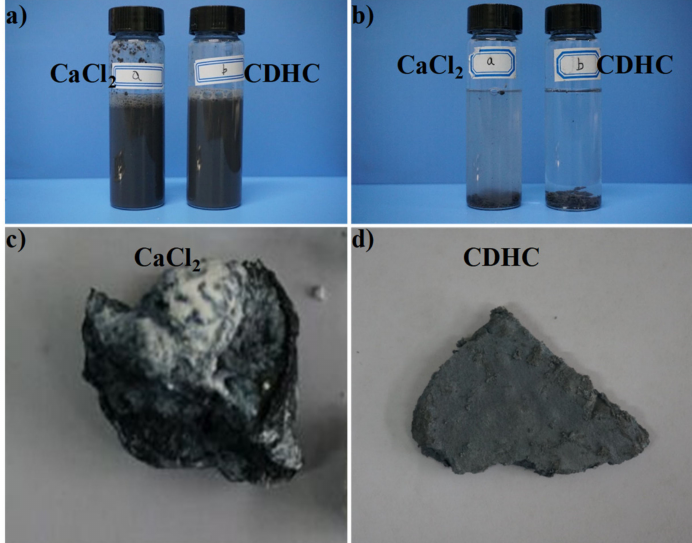
Figure 3. The di ff erence of the coagulation e ff ect of CaCl 2 (left) and CDHC (right) on the rGO / silica / NR latex mixture in di ff erent periods ( a ) adding coagulation agents; ( b ) the coagulated and filtered sample was re-added into water; ( c ) the CaCl 2 coagulated sample; ( d ) the CDHC coagulated